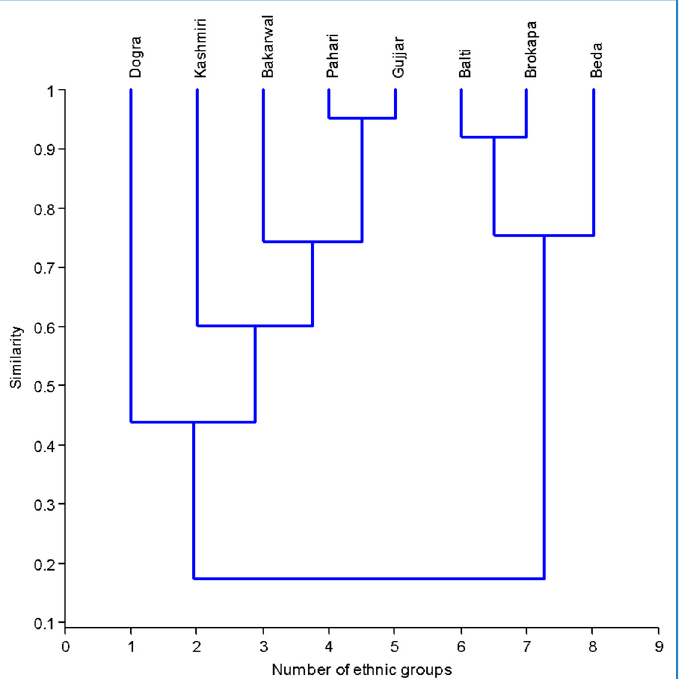
Figure 9. Dendrogram representing clustering of investigated ethnic groups among different re- gions.